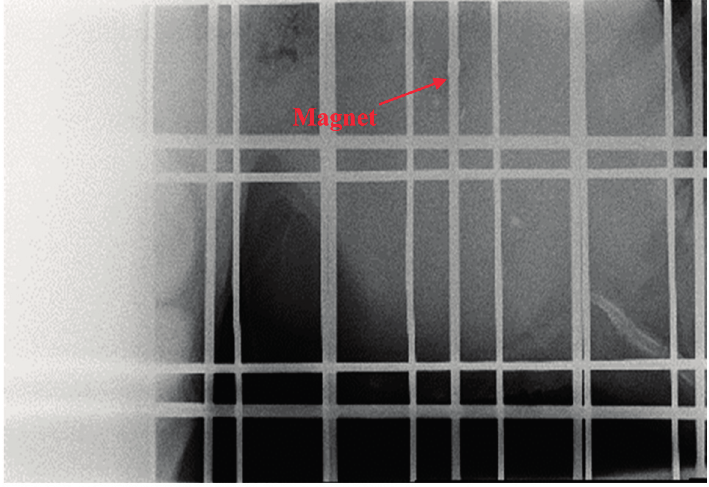
Figure 17. Location of the magnet is verified by